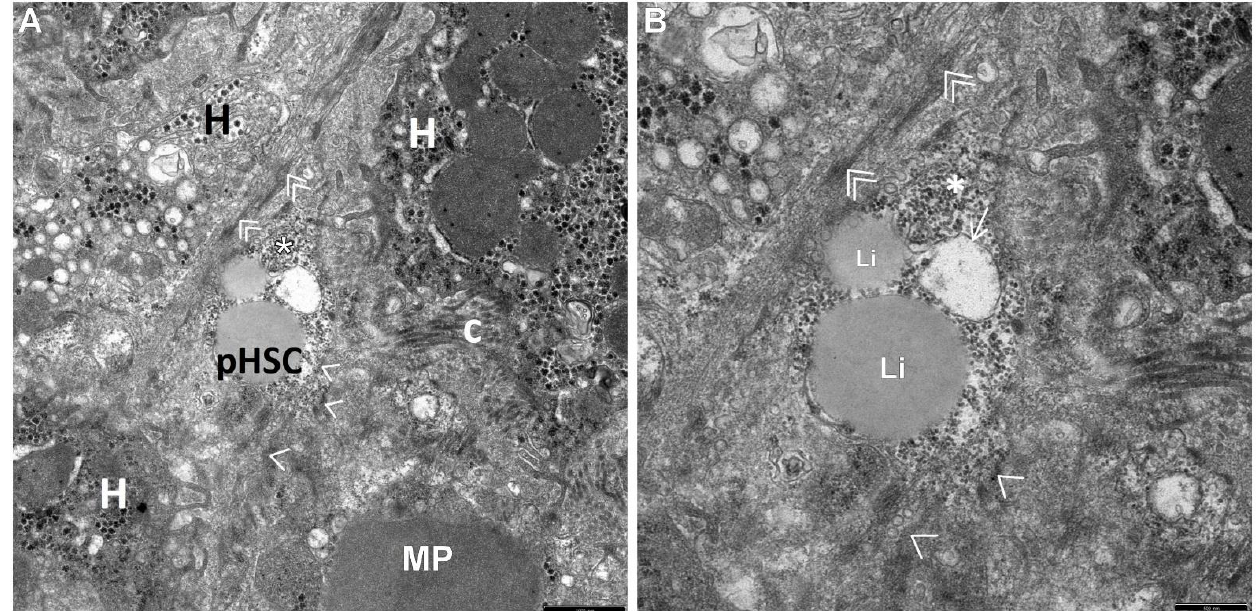
Figure 4. ( A , B ) An ultrastructural picture of a T-HSC, with features of pHSC, which lost a part of lipid material (Li) and is surrounded by hepatocytes (H) and an activated macrophage (MP). A tiny bundle of collagen fibers (c) is seen to adhere to the pHSC. The pHSC cytoplasm shows section through a markedly cistern-like dilated ger channel (->), almost completely deprived of ribosomes and with fine microfibrillar material; around this ger channel, there are areas of the cytoplasm rich in free ribosomes (*); also visible are submembranous linearly accumulating bundles of microfilaments (>>) (i.e., submembranous dense areas). Between the pHSC and MP, there are tight intercellular junctions (>). Scale bar 1 µ m, original magnification × 7000 ( A ); scale bar 0.5 µ m, original magnification × 12,000 ( B